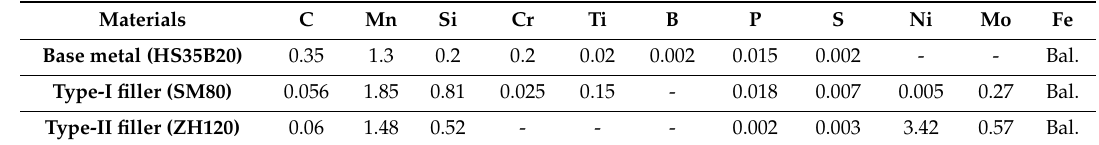
Table 1. Chemical composition of materials